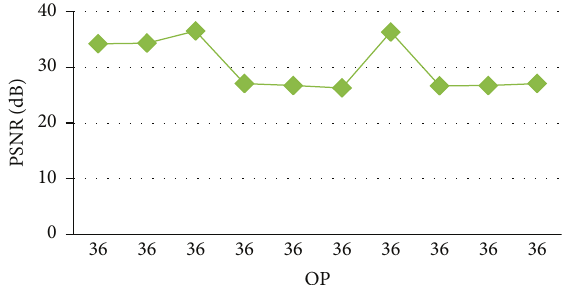
Figure 10: Evaluation of the PQA: impact of the Quantization Parameter (QP) on PSNR.